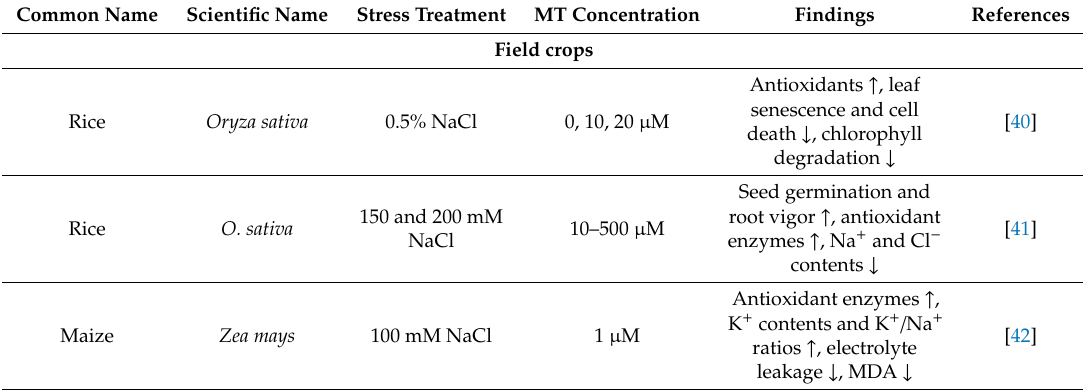
Table 1. Primitive impact of exogenous melatonin application on di ff erent salt-stressed